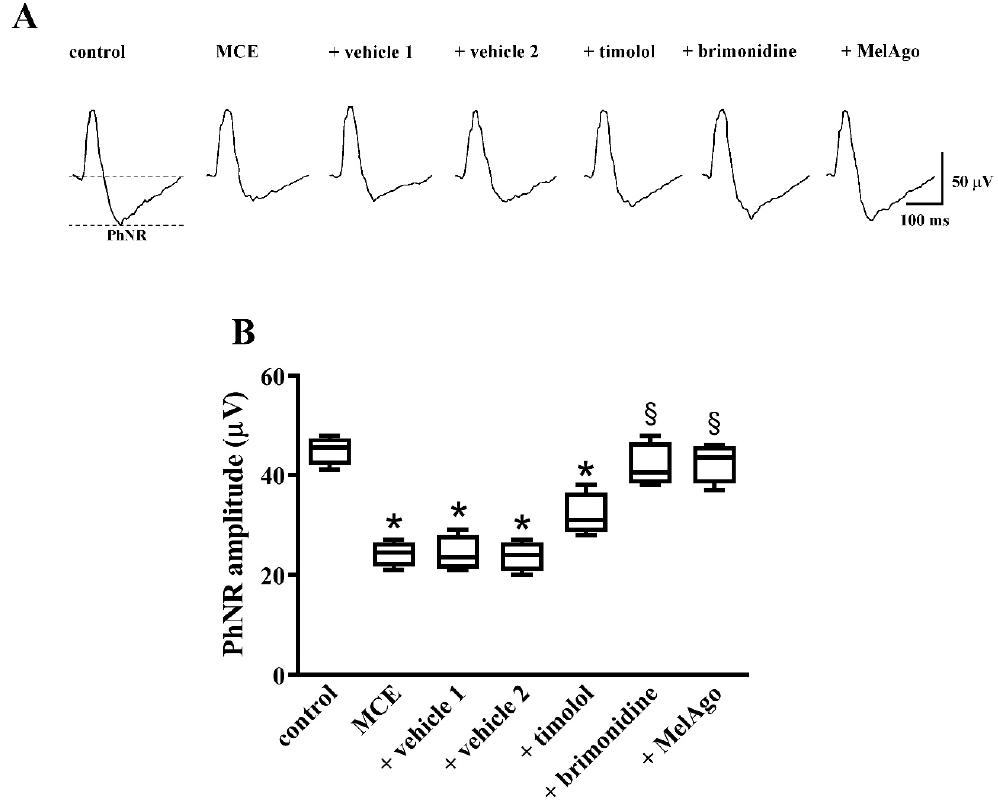
Figure 2. Retinal function as evaluated by photopic full-field electroretinogram (ERG). ( A ) Representative ERG traces showing photopic b-waves with photopic negative response (PhNR) in control rats and in rats that received intraocular MCE injection either untreated or treated with vehicles, timolol, brimonidine or melatonin / agomelatine. ( B ) Mean amplitudes of PhNR evaluated as changes from baseline. MCE reduced the PhNR amplitude. Neither vehicles nor timolol a ff ected the PhNR amplitude that was almost recovered to control values by brimonidine or melatonin / agomelatine. Data are shown as box and whiskers plots ( n = 6 animals for each experimental group). * p < 0.05 versus control; § p < 0.05 versus the respective vehicle (one-way ANOVA followed by Tukey post-hoc test). MelAgo, melatonin /